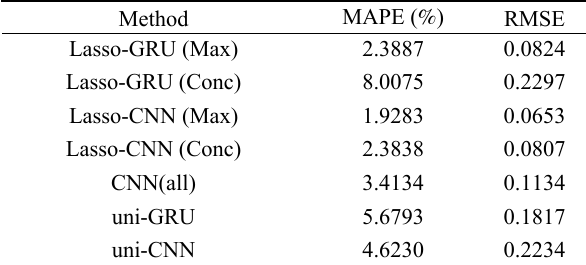
Table 2 MAPE and RMSE of forecasting gasoline prices of the entire nation based on both the new method and alternative